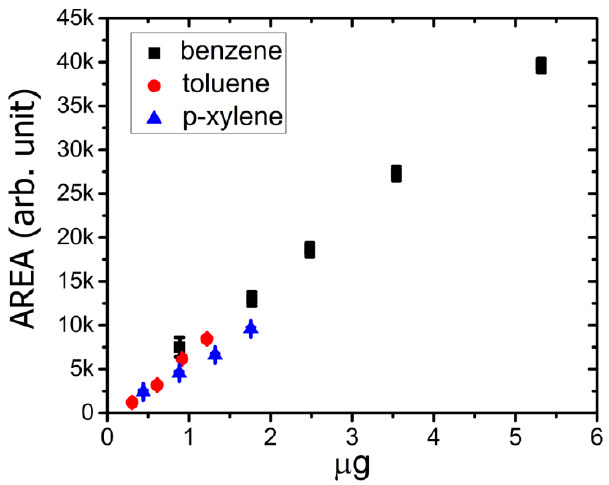
Figure 7. Response vs. injected mass of BTX. In particular, the peak areas versus the amount of compound in the injected sample (expressed in µg) are shown, including the error bar.